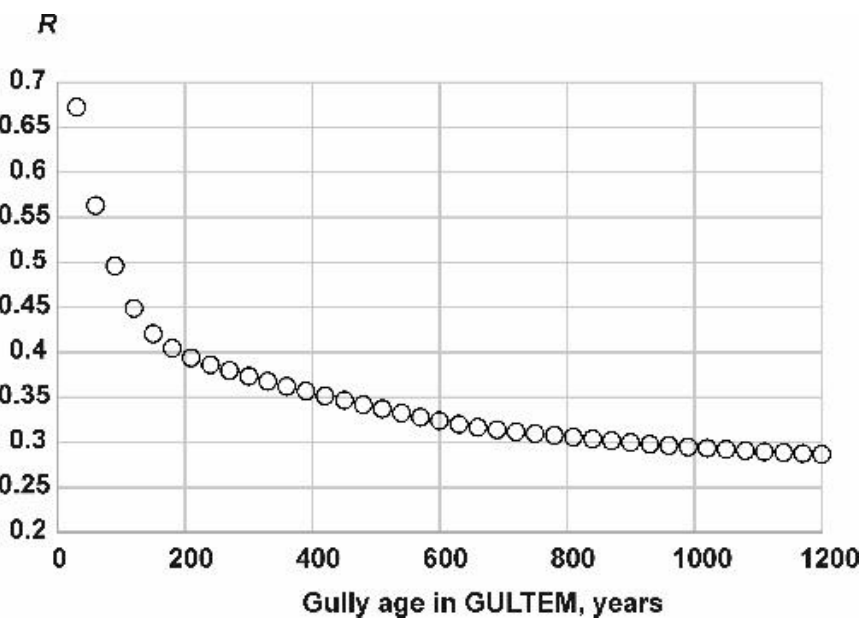
Figure 7. The decrease of correlation with the increase of prediction time between total erosion po- tential, calculated with the TEP model, and gully depths, calculated with GULTEM. potential, calculated with the TEP model, and gully depths, calculated with